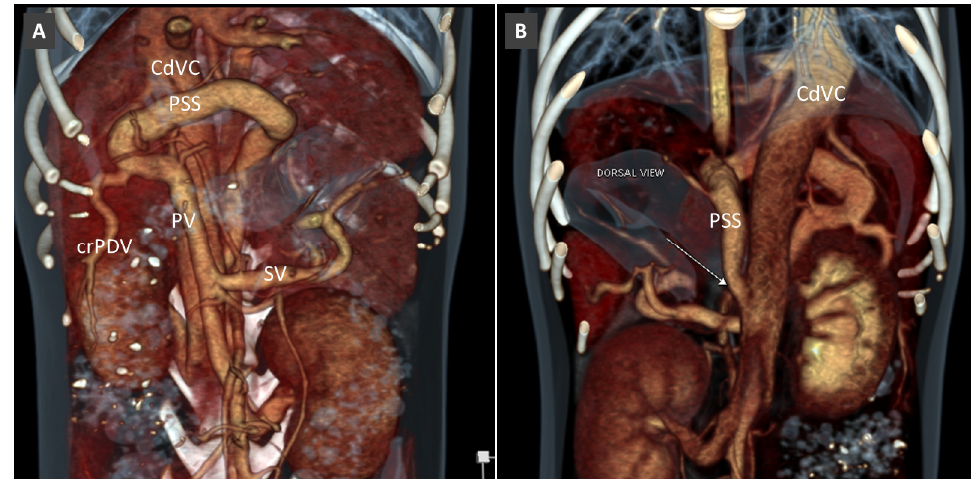
Figure 15. Extrahepatic congenital PSS from right gastric vein to the pre-hepatic segment of the caudal vena cava (CdVC). ( A ). Volume rendered image, ventral view (CrPDV, cranial pancreatic duodenal vein). ( B ). Dorsal view showing the site of the insertion of the PSS into the CdVC.